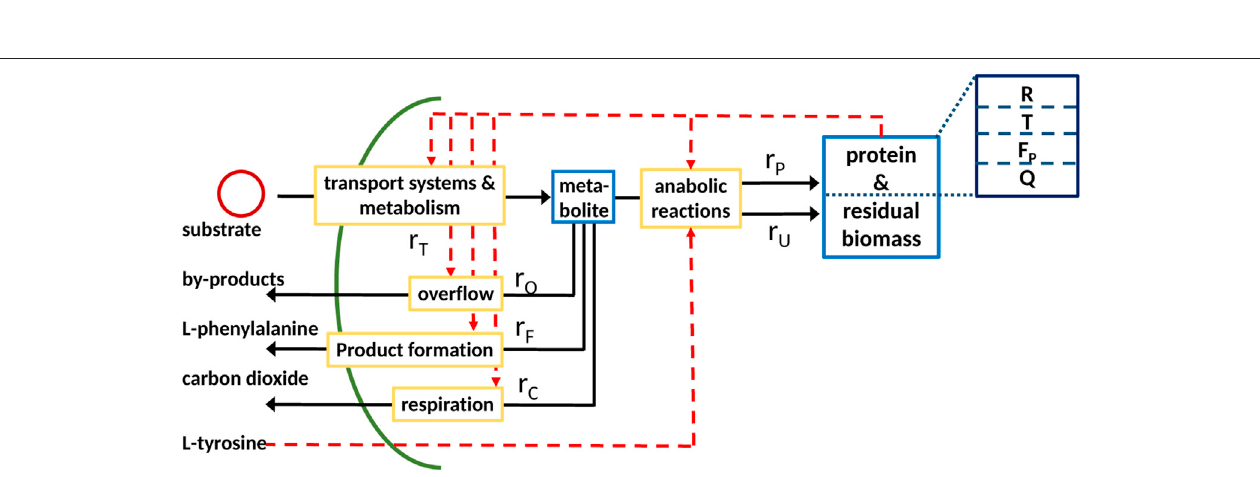
Frontiers in Molecular Biosciences |